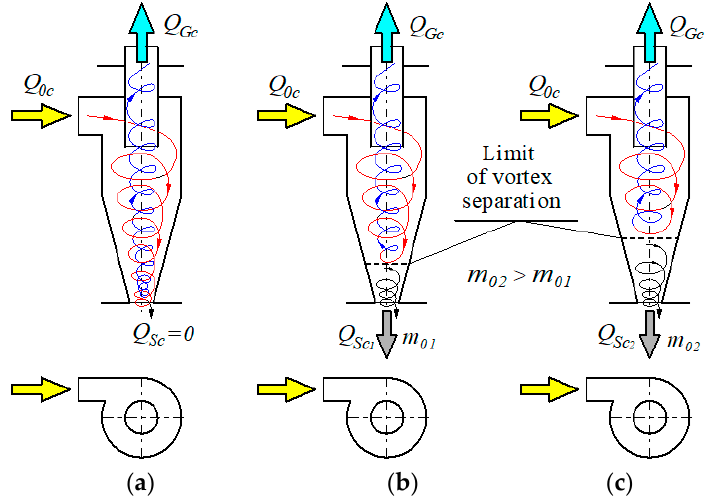
Figure 9. The flow of the air through a reverse-flow cyclone with a tangential inlet: ( a ) without suction and ( b , c ) with suction of different intensities.